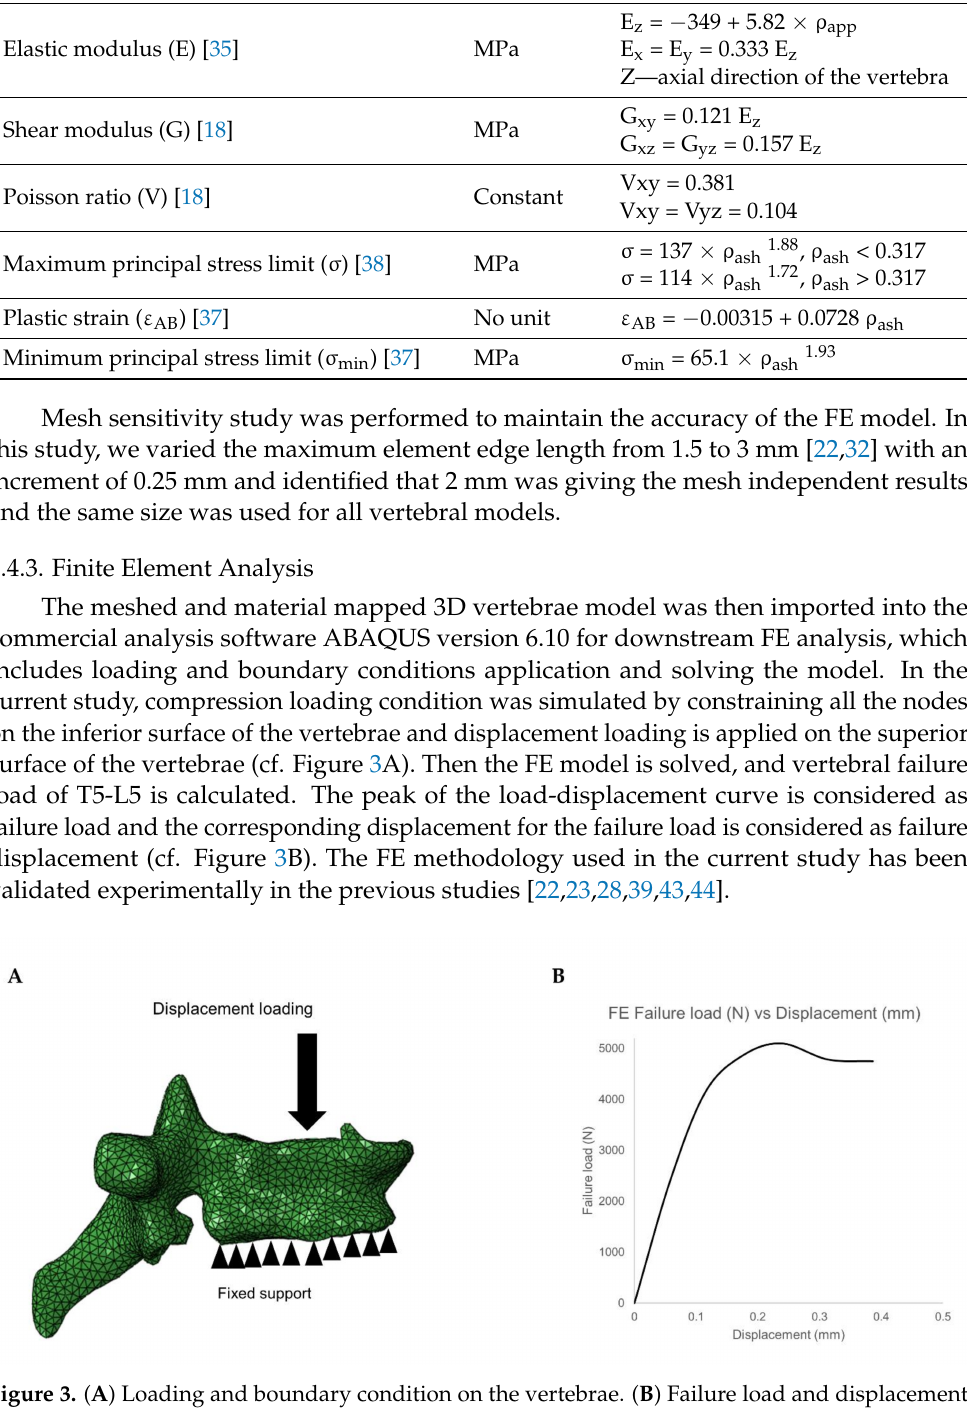
Figure 3. ( A ) Loading and boundary condition on the vertebrae. ( B ) Failure load and displacement variation for the vertebrae under compressive loading